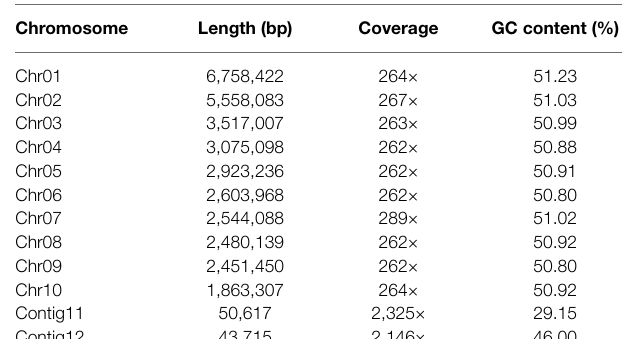
TABLE 1 | Summary of genome assembly statistics for A. alternata